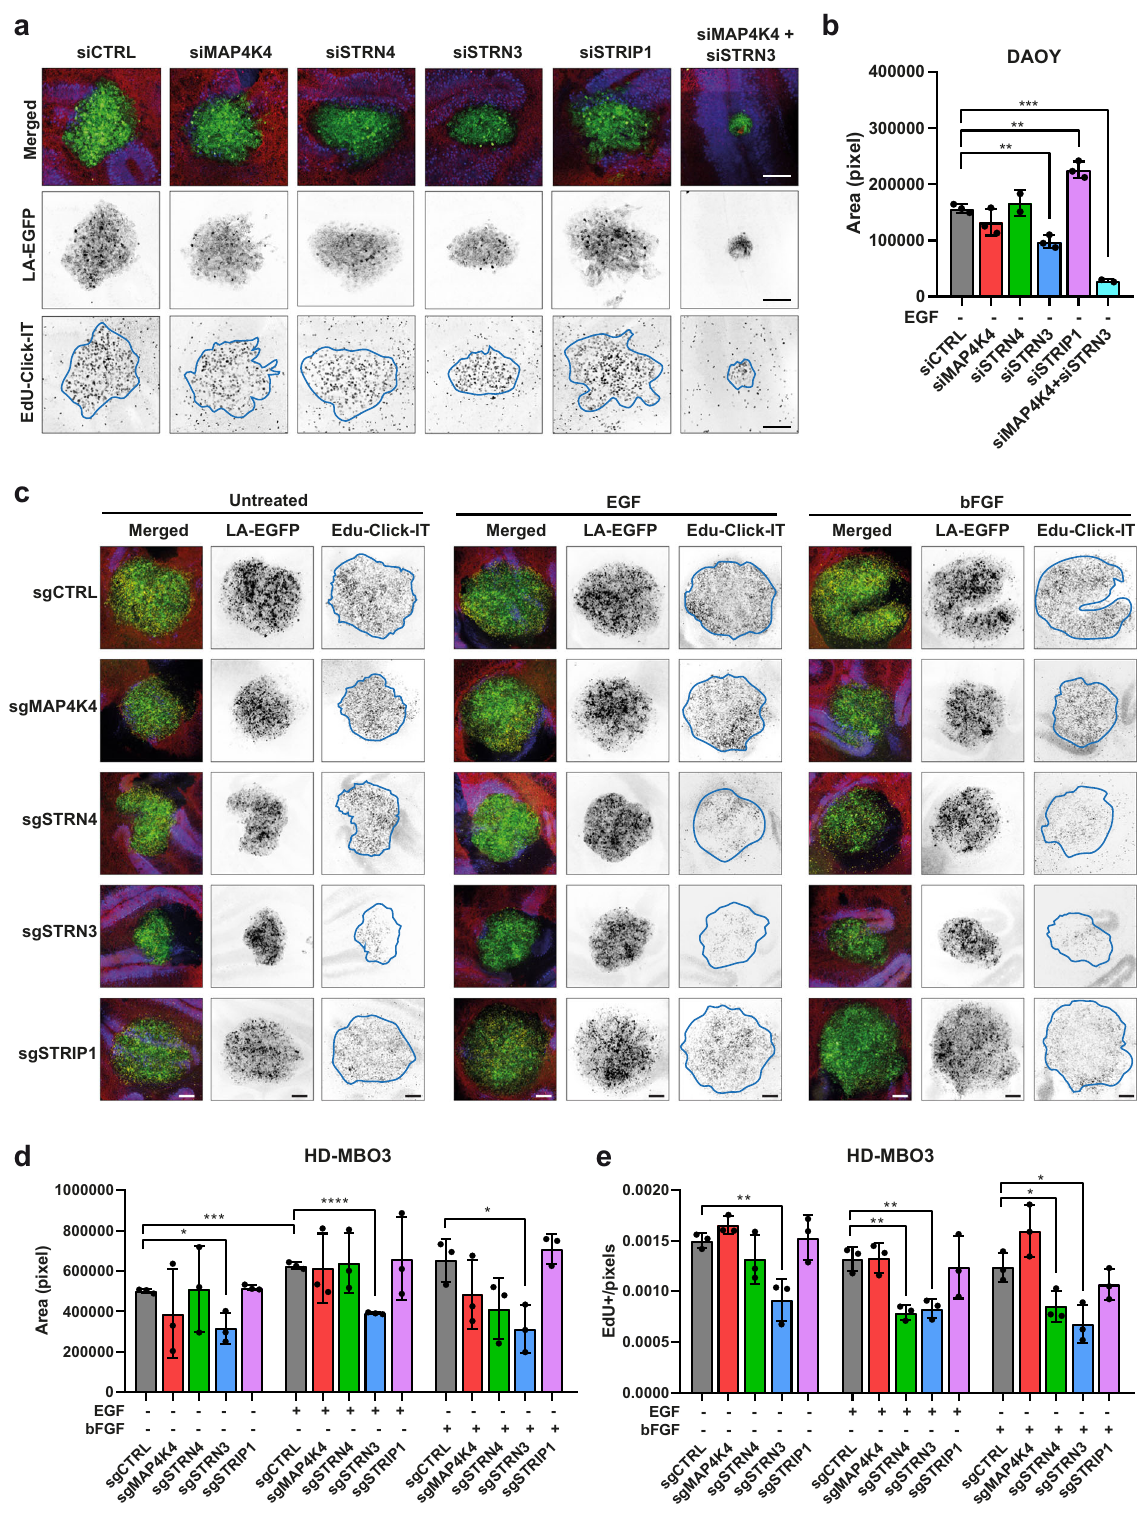
target genes induced by STRN3 or STRN4 depletion was rescued to control levels by the concomitant depletion of MAP4K4 (Fig. 4c). The STRIPAK phosphatase PP2A antagonizes Hippo kinases and promotes a YAP/TAZ transcriptional program 21,42 . Con- sistently, PP2A inhibition by LB-100 repressed transcription of YAP/TAZ target genes and exactly phenocopied the depletion of